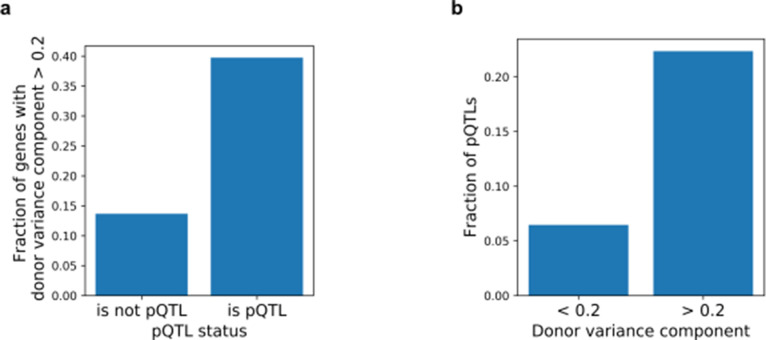
Relationship between estimates of donor variance component and cis pQTLs.(a) Barplot showing the fractions of genes with significant variance donor component for genes with and without cis pQTLs. (a) Barplot showing the fractions of genes with a cis pQTL for genes stratified by the relative donor variance.